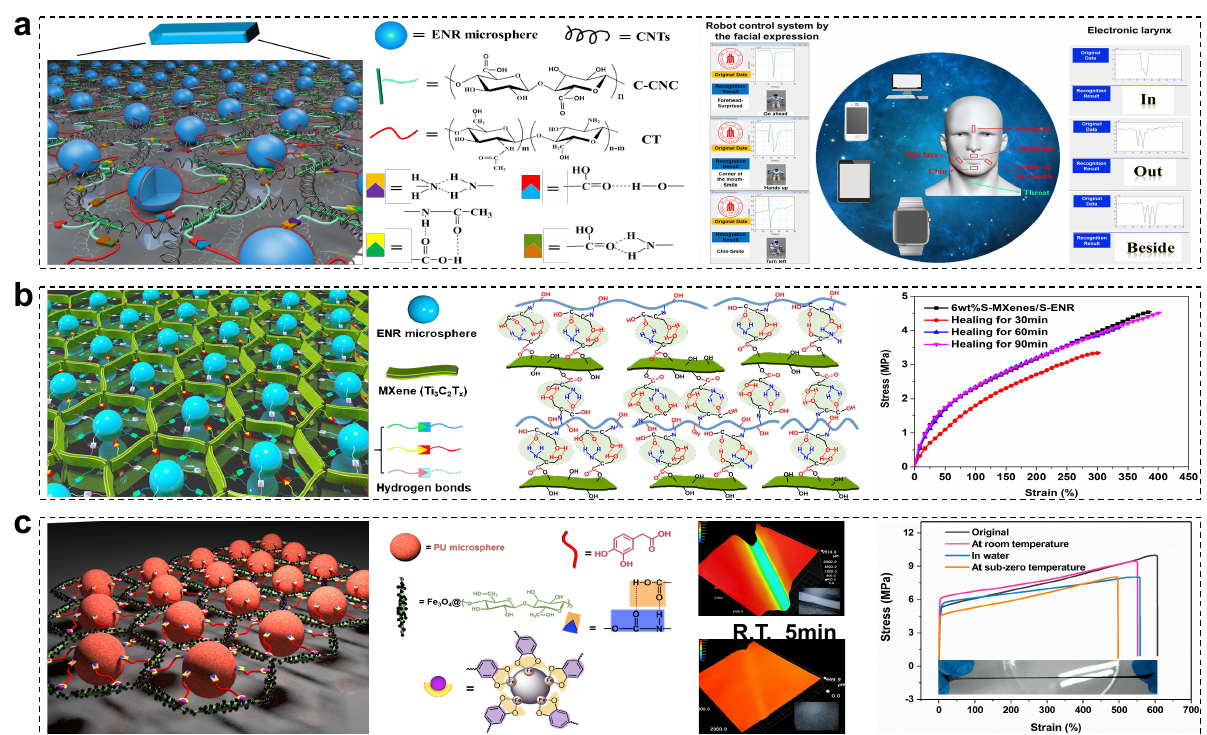
Figure 7. ( a ) Proposed supramolecular multiple hydrogen bonding network combined with nanos- tructured CNT conductive network design in ENR latex microspheres. Robot control system by the facial expression and electronic larynx based on the self-healing strain sensors. Reproduced with permission [173]. Copyright 2017, Wiley-VCH. ( b ) Interfacial supramolecular hydrogen bonds combined with the 3D segregated conductive networks design in NMSE. Corresponding chemical structure of interfacial hydrogen bonds between S-MXene nanosheets and S-ENR chains. Tensile curves of resultant self-healing elastomer at different self-healing times. Reprinted with permission from ref. [174]. Copyright 2020 American Chemical Society. ( c ) Schematic illustration for hierarchical structural design and interfacial supramolecular crosslinking in PU matrix. The super depth of field microscope images of samples before and after healing process. Stress-strain curves of samples healed at room temperature and under different harsh conditions. Reproduced with permission